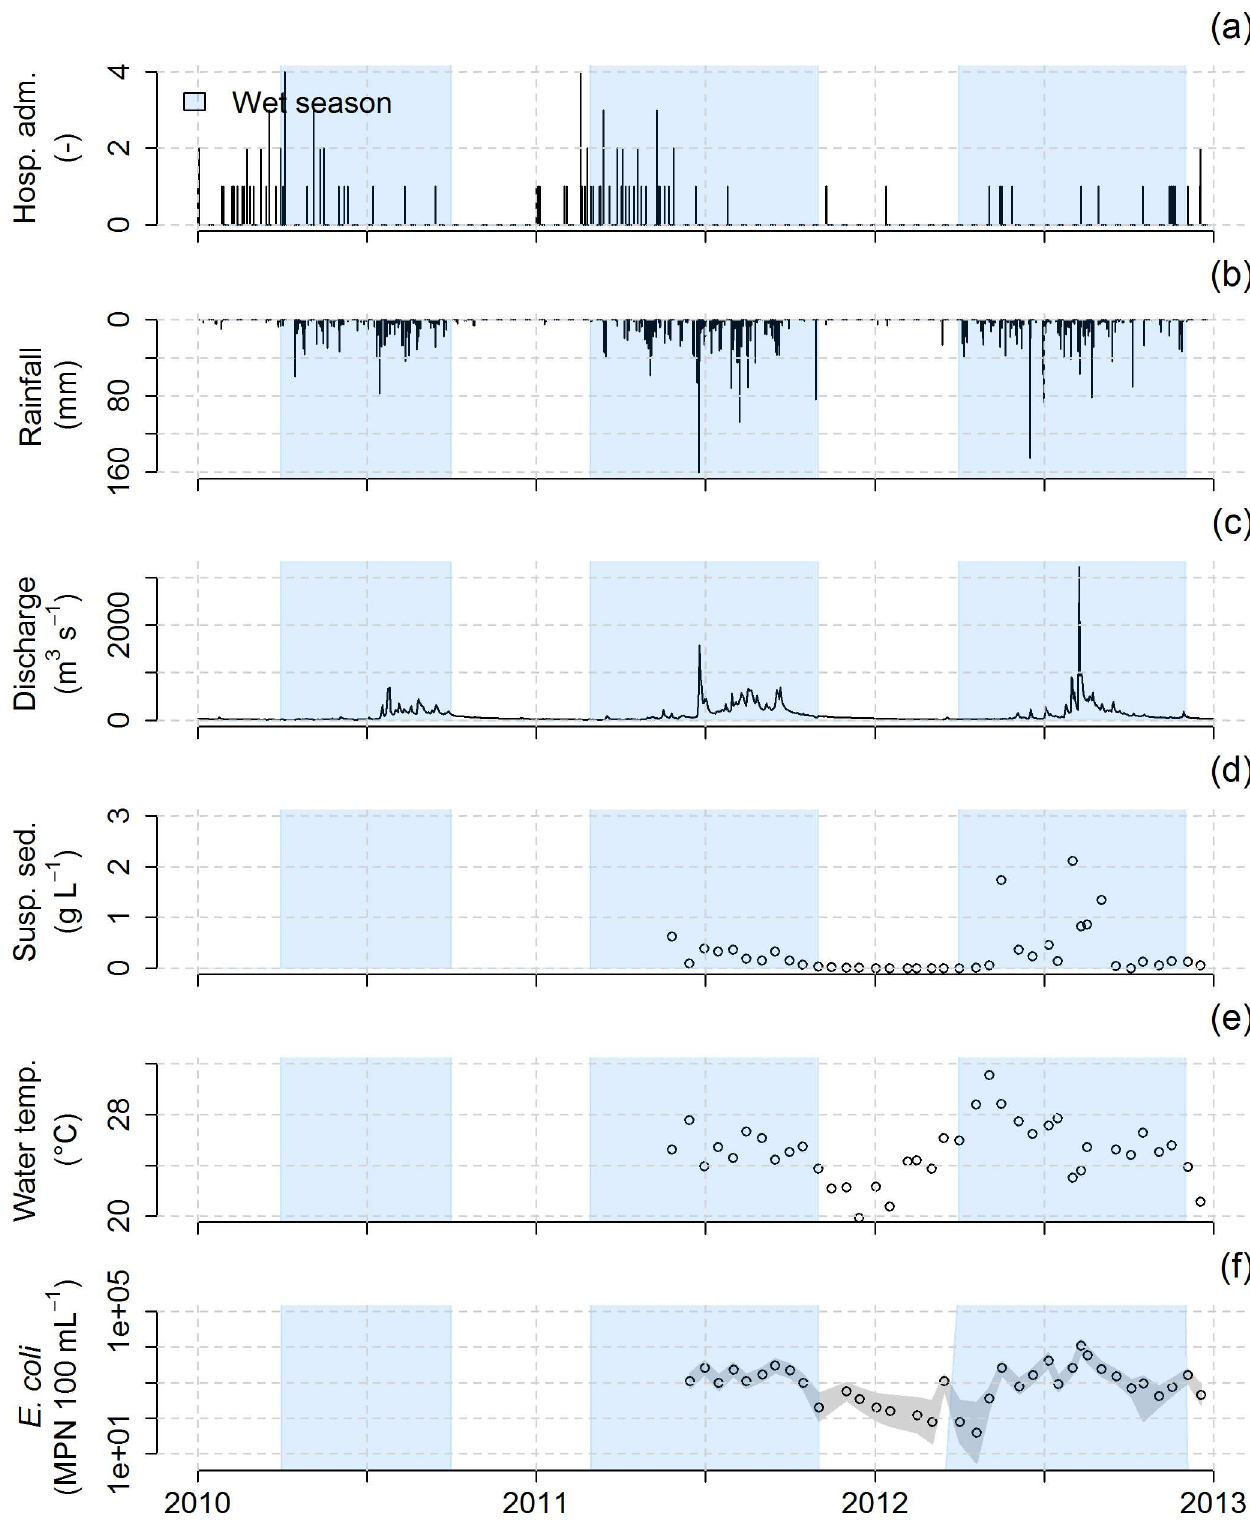
Fig 4. (a) Daily reporteddiarrhealdiseasecases (i.e., hospitaladmissions)recordedin the Xieng Ngeundistrict, Laos, from 2010 to 2012, (b) Daily rainfall(mm) recordedat the Luang PrabangAirport meteorological station, (c) Daily discharge(m 3 s -1 ) recorded at the NK20 sampling station, (d) Biweeklymonitoringof suspendedsediments(g L -1 ) at NK20, (e) Biweeklymonitoringof water temperature (˚C) at NK20, and (f) Biweeklymonitoring of E . coli counts (MPN 100 mL -1 ) at NK20. doi:10.1371/journal.pntd.0005195.g004 PLOS NeglectedTropical Diseases | DOI:10.1371/journal.pntd.0005195 December 9,